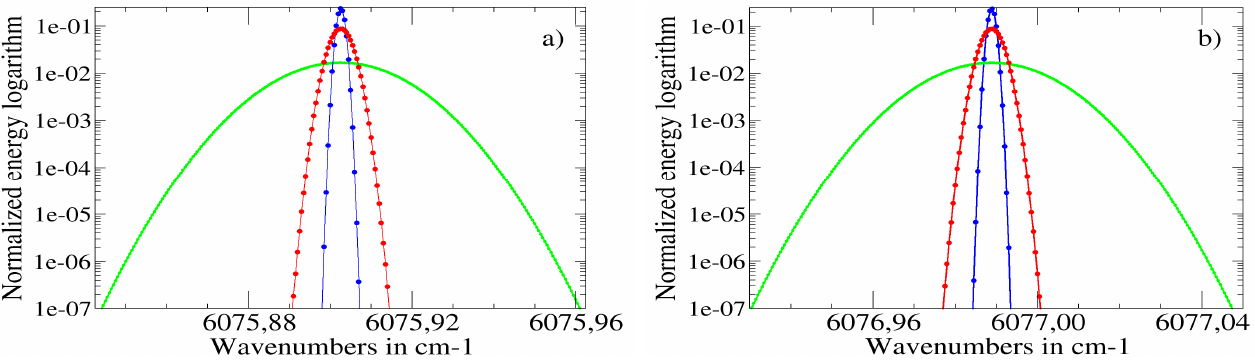
Figure 12. For ( a ) the Off and ( b ) the On beam, the dependence of the logarithm of the energy on the wavenumber: emitted (blue), after Doppler broadening by molecules at 300 K (green) or by particles (assumed 32 times heavier than molecules) at 300 K (red). The dots are at the spectral resolution of the 4A computations (5 × 10 − 4 cm − 1 ).